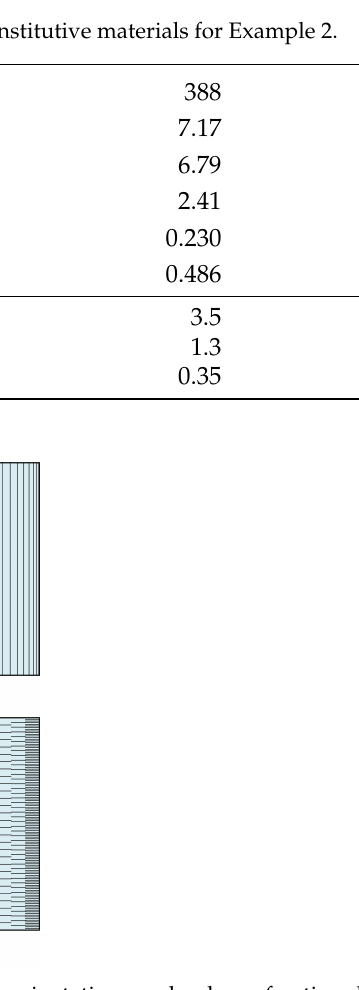
Figure 6. Schematic representation of fiber orientations and volume fraction distributions for the FGM composite plate considered in Example 2; ( a ) 90 ◦ , p = 0; ( b ) 90 ◦ , p = 1; ( c ) 0 ◦ , p = 0; ( d ) 0 ◦ , p =